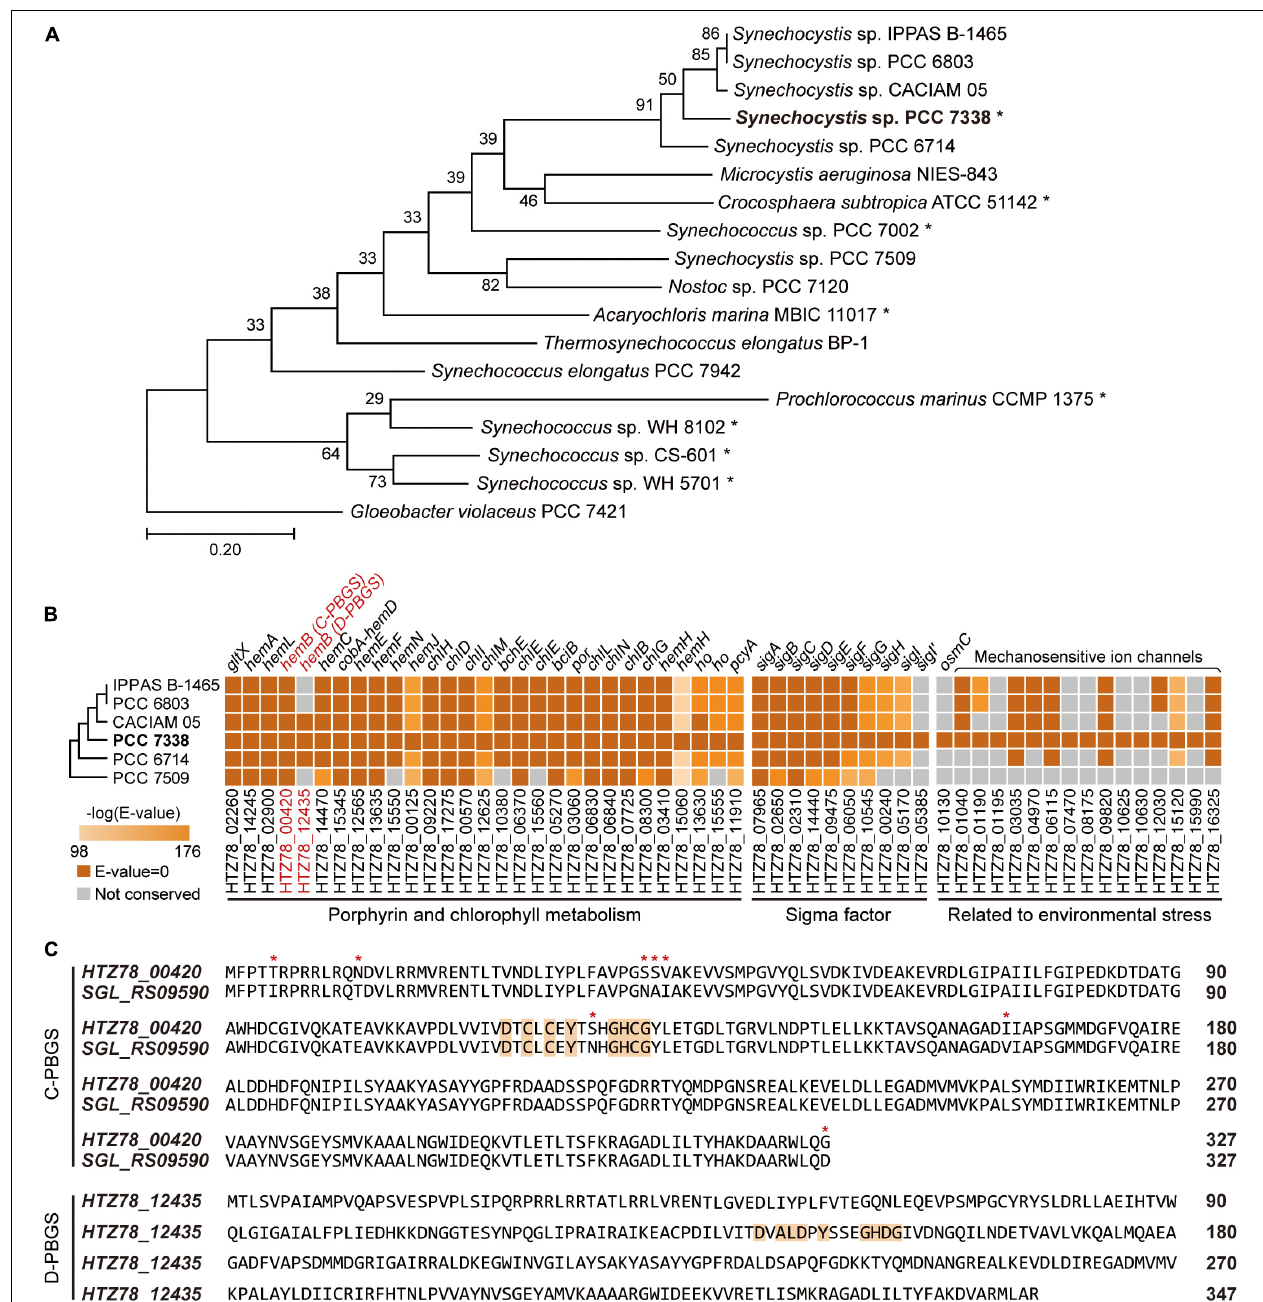
FIGURE 1 | Genome completion of Synechocystis sp. PCC 7338 and comparison with other cyanobacteria. (A) Phylogenetic analysis of Synechocystis sp. PCC 7338 and 12 genome sequenced cyanobacteria. Gloeobacter violaceus PCC 7421 was selected as the outgroup. The evolutionary distances were calculated by Up-to-date Bacterial Core Gene analysis pipeline (UBCG) and represented by Randomized Axelerated Maximum Likelihood (RAxML). Asterisks indicate marine cyanobacteria. (B) Comparison of gene sequences related to porphyrin and chlorophyll metabolism, sigma factors, and environmental stress in six Synechocystis sp. strains by BLASTP search. The names of strains are indicated with omitted species name ( Synechocystis sp.). The extra sigma factor detected only in Synechocystis sp. PCC 7338 was denoted as SigI’. The tree is not to scale. Keys: C-PBGS, cysteine-rich porphobilinogen synthase; D-PBGS, aspartate-rich porphobilinogen synthase. (C) The amino acid sequences of C-PBGS in Synechocystis sp. PCC 7338 (HTZ78_00420) and Synechocystis sp. PCC 6803 (SGL_RS09590) and D-PBGS in Synechocystis sp. PCC 7338 (HTZ78_12435). The amino acid sequences of the other Synechocystis species are compared in Supplementary Figure 1B . Orange boxes indicate the active sites and red asterisks indicate the varying sequences.